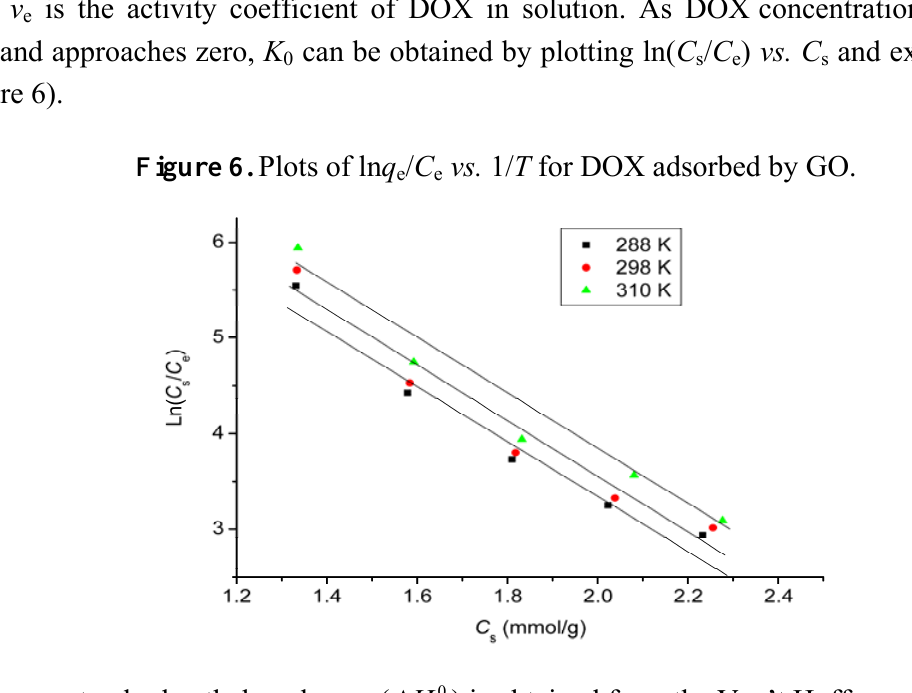
Figure 6. Plots of ln q